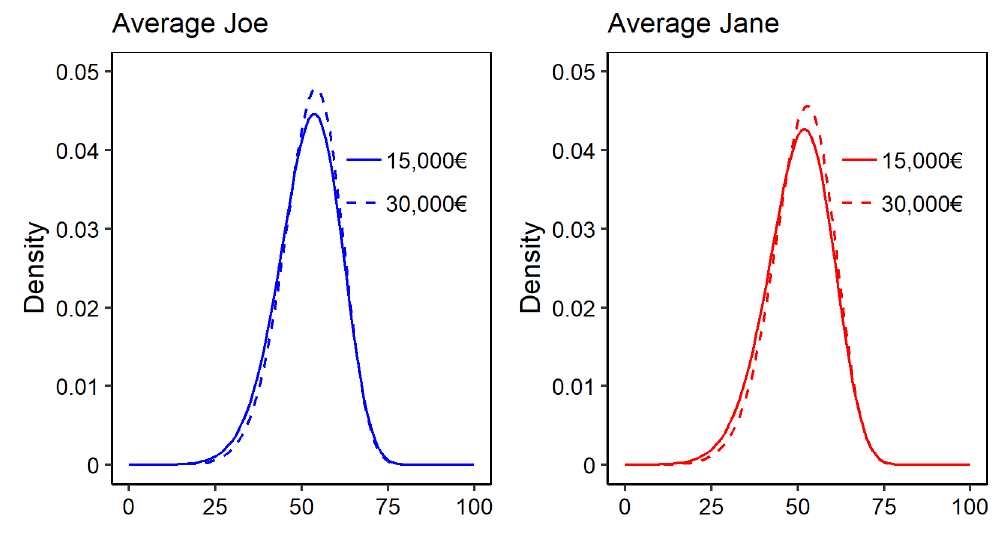
Figure 4. Estimated conditional density of average Joe (blue) and Jane (red) at income levels of 15,000 e and 30,000 e